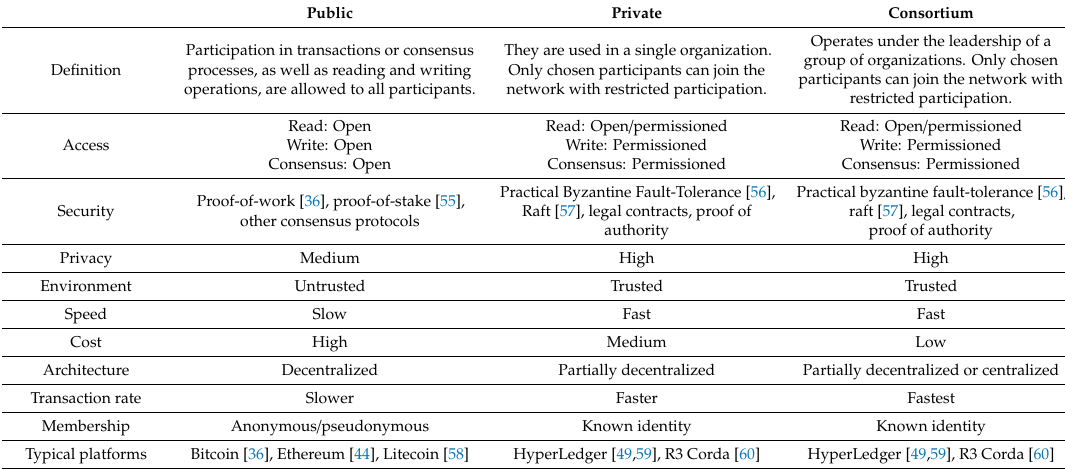
Table 2. Blockchain types (public, private, and